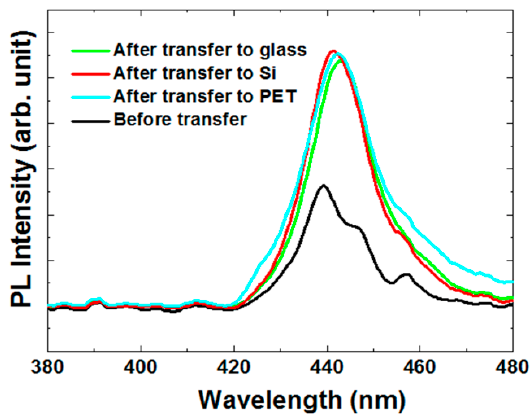
Figure 4. PL spectra of GaN LEDs before and after transfer onto various substrates.